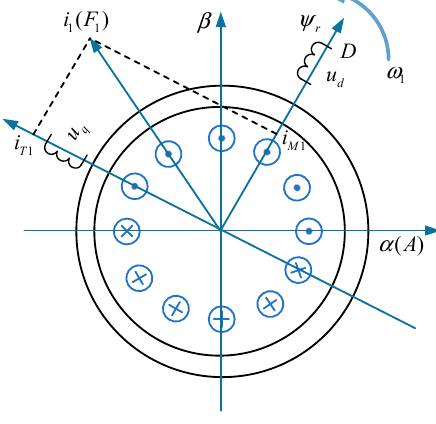
Figure 2. Rotor flux orientation.